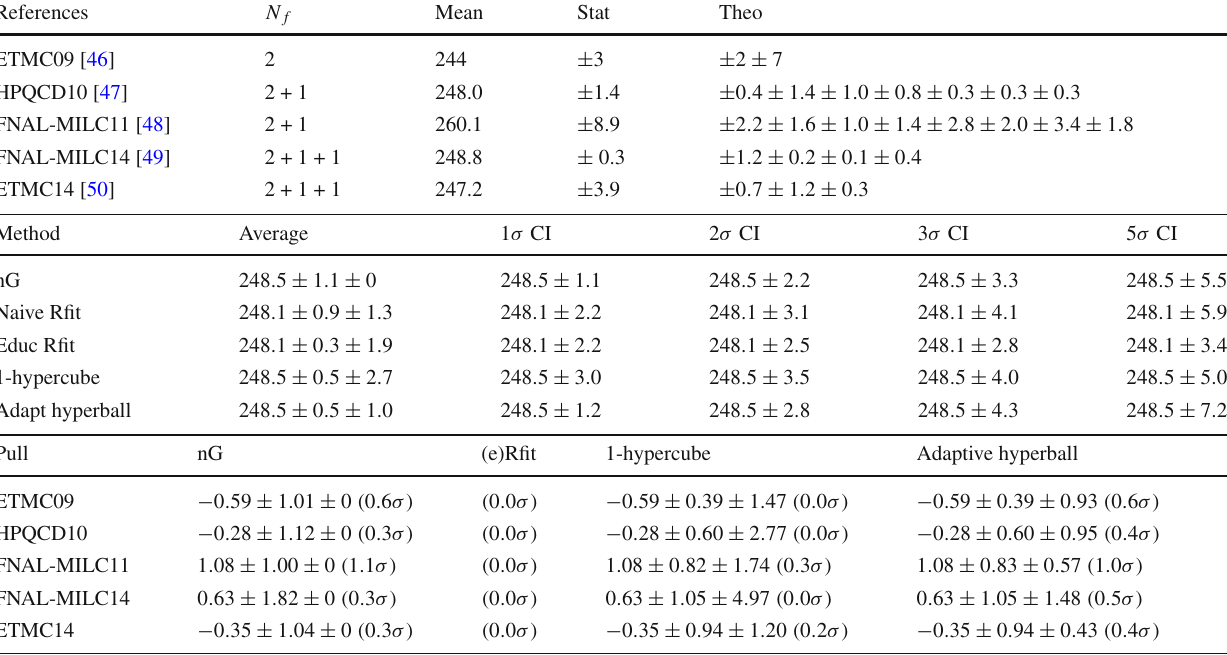
Table 7 Top: lattice determinations of the D s -meson decay constant f D (in MeV). Middle: averages according to the various methods, and s corresponding confidence intervals for various significances. Bottom: pullassociatedtoeachmeasurementforeachmethod.ForRfitmethods,